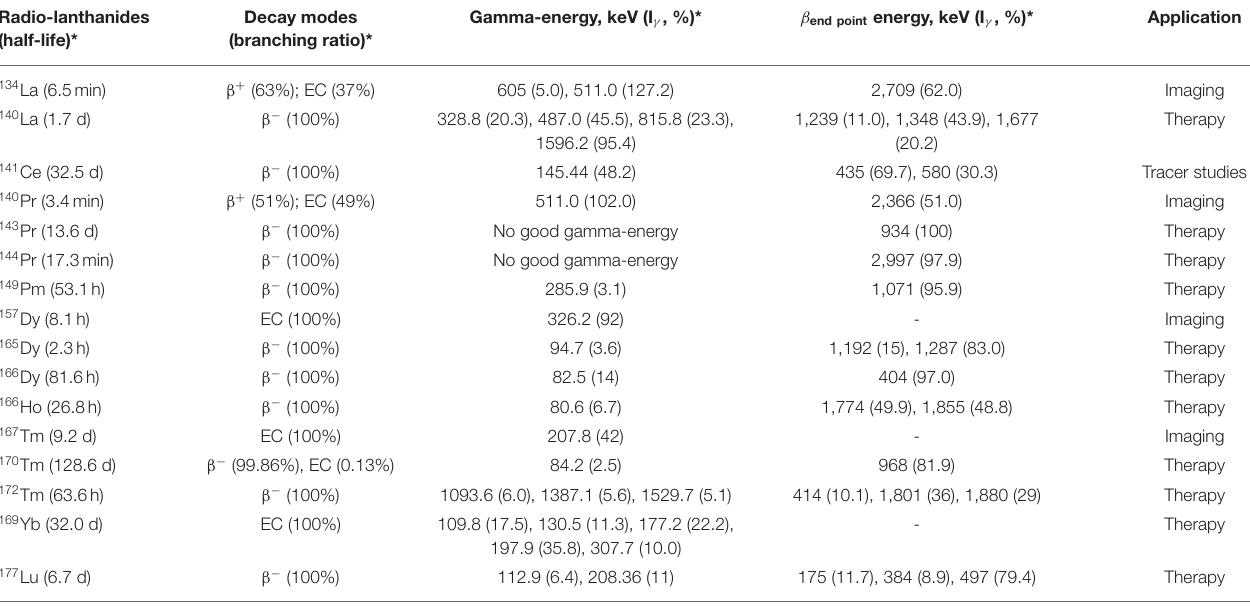
TABLE 1 | Some potential radio-lanthanides proposed in nuclear medicine. Radio-lanthanides